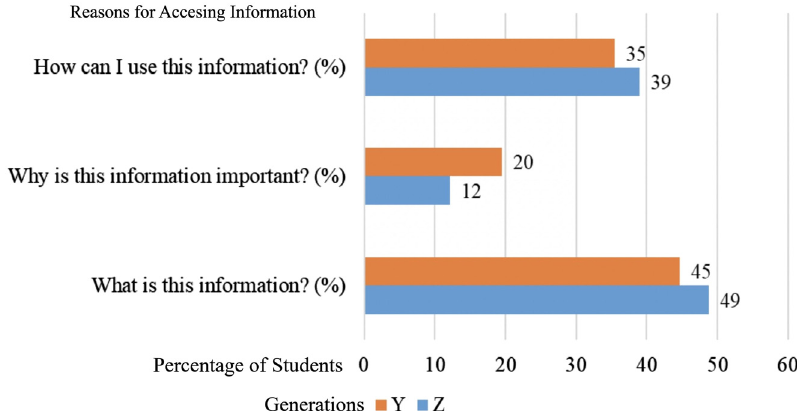
Figure 5: The reasons of students ’ research of